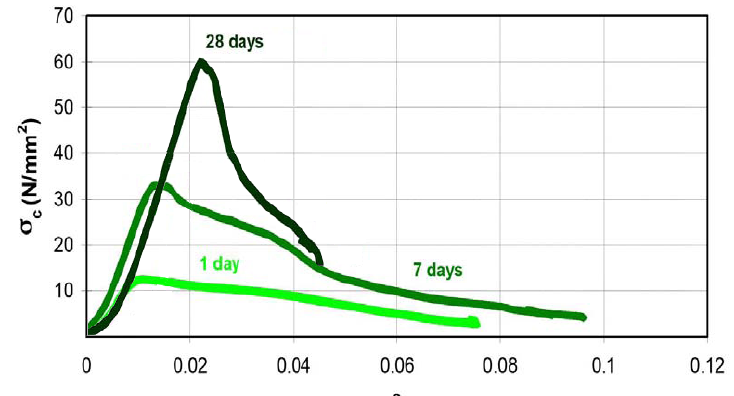
Figure 8: Comparison between  curves of reference mortar in function of the curing days (1, 7, and 28 days).